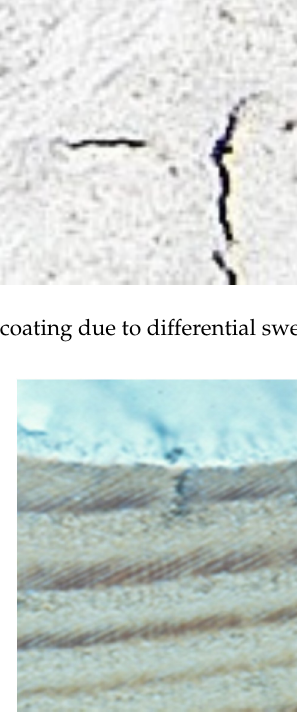
Figure 8. Cross ‐ section cut ‐ through an exposed board, showing a small crack developing due to wood swelling as the coating fails [1].